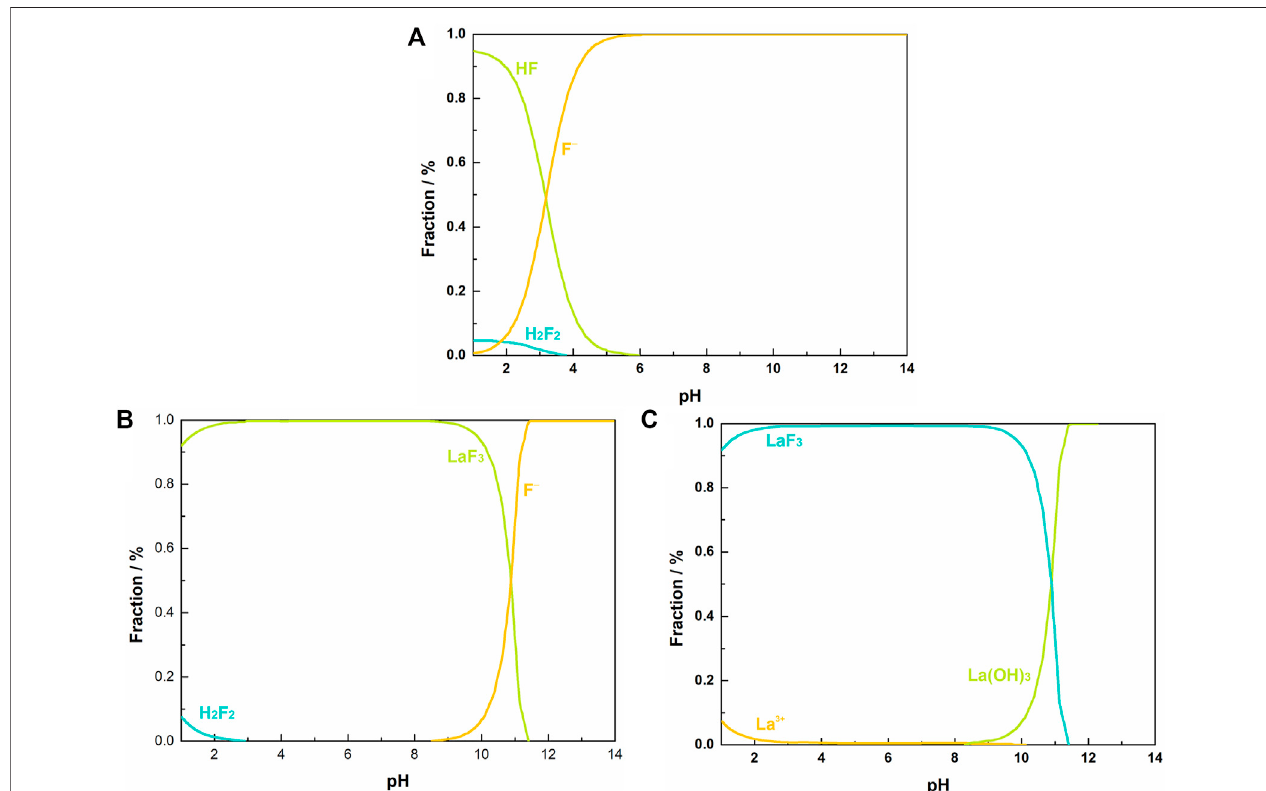
FIGURE 1 | Aqueous equilibrium diagram: (A) fraction of fl uorine species in F-H2O system at 298 K, [F]T = 0.01 M; fraction of fl uorine species (B) and lanthanum species (C) in La-F-Cl-H2O system at 298 K, [La]T = 0.0053 M, [F]T = 0.0158 M, [Cl]T = 0.0338 M.